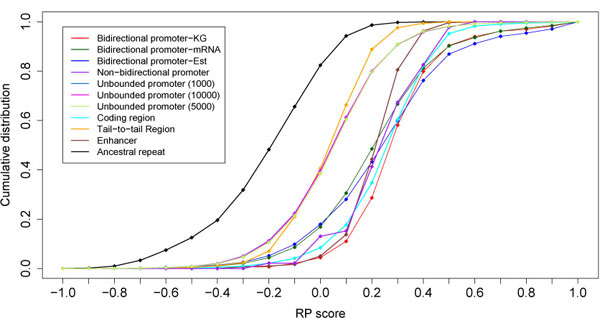
Cumulative distribution functions of RP scores for different functional classes. These include bidirectional promoters (red, green, blue), non-bidirectional promoters (purple) and unbounded promoters (light blue, pink, light green). Other functional elements are coding regions (aqua), tail-to-tail regions (yellow) and enhancers (maroon). The nonfunctional elements are represented by ancestral repeats (black).